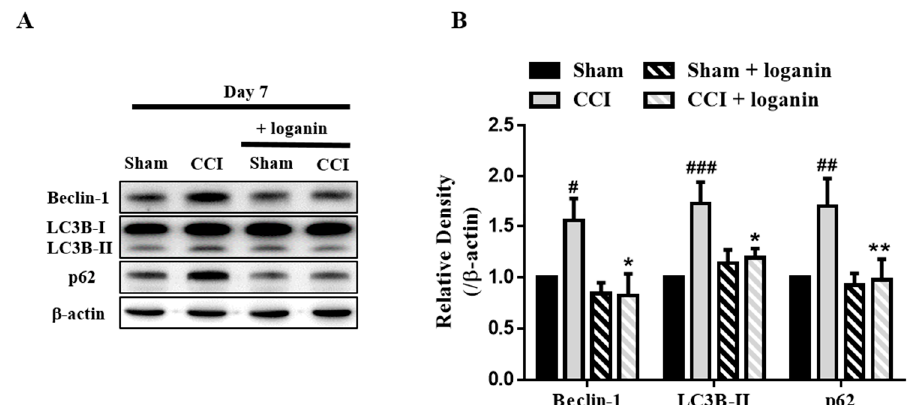
Figure 1. Effects of loganin (5 mg/kg/day, i.p.) on autophagy-related proteins, Beclin-1, LC3B-II, and p62 in the spinal cord on day 7 after chronic constriction injury (CCI). ( A ) Representative Western blot analysis of autophagy marker Beclin-1, LC3B-II, and p62 proteins. ( B ) Quantification of Western blot data in A. Sham-operated rats were the subjects of the same procedure without nerve manipulation. These data represent the mean ± SE for 6 rats per group. # p < 0.05, ## p < 0.01, ### p < 0.001 compared with the sham group at the corresponding time points; * p < 0.05, ** p < 0.01 compared with the CCI group.